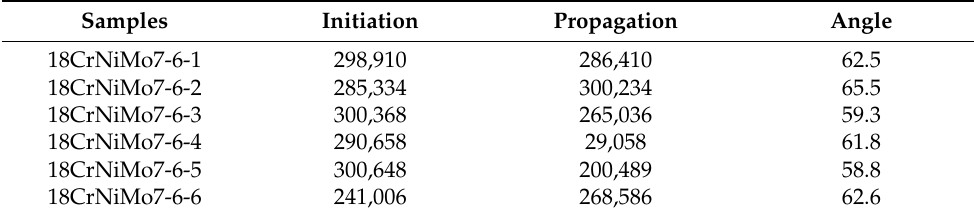
Table 4. Cycle numbers and angles recorded for tooth root fatigue cracks.